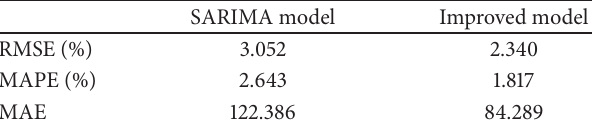
Table 7: The error of